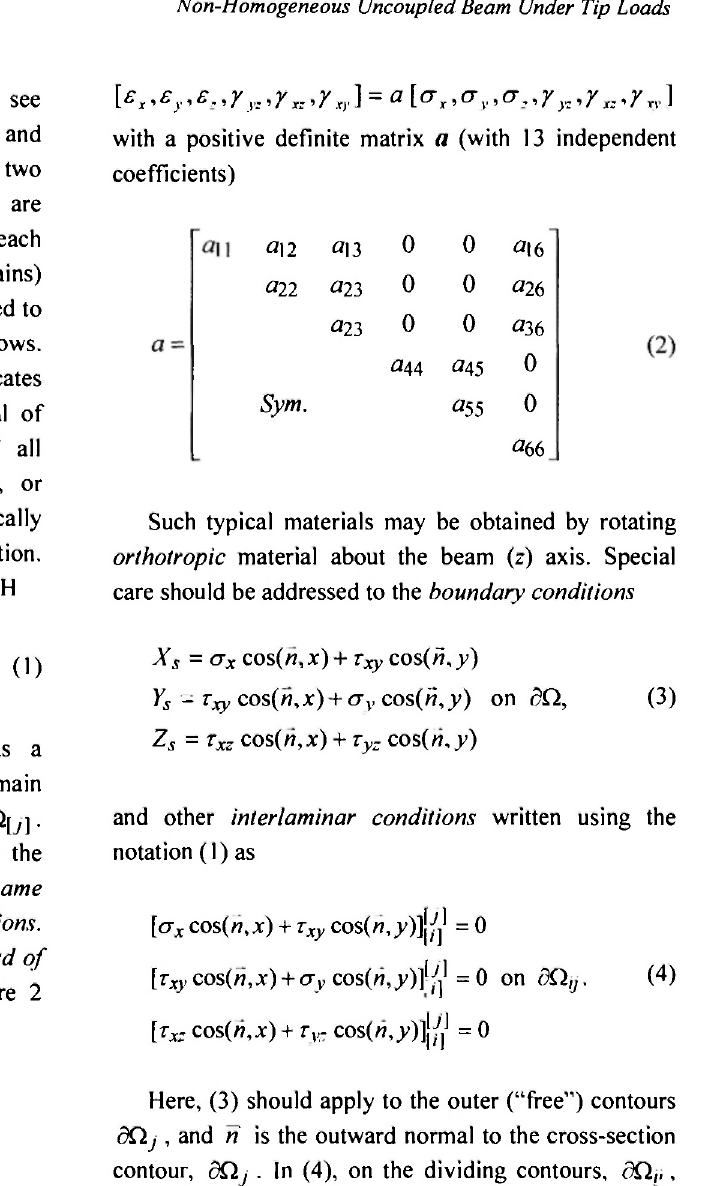
Fig. 2: Normal orientation notation: nj is directed outward of region Qjy] (j =